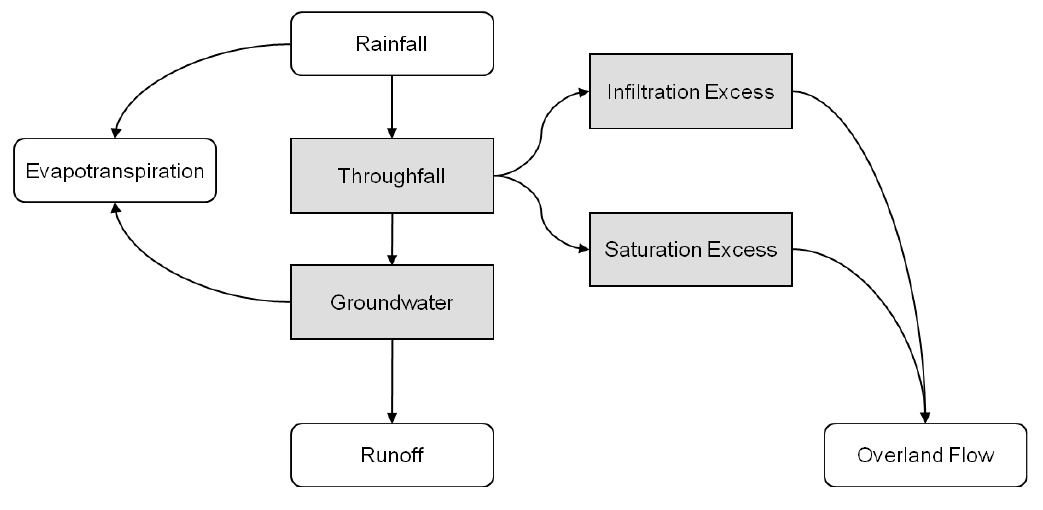
Figure A1.2: Hydrological submodel